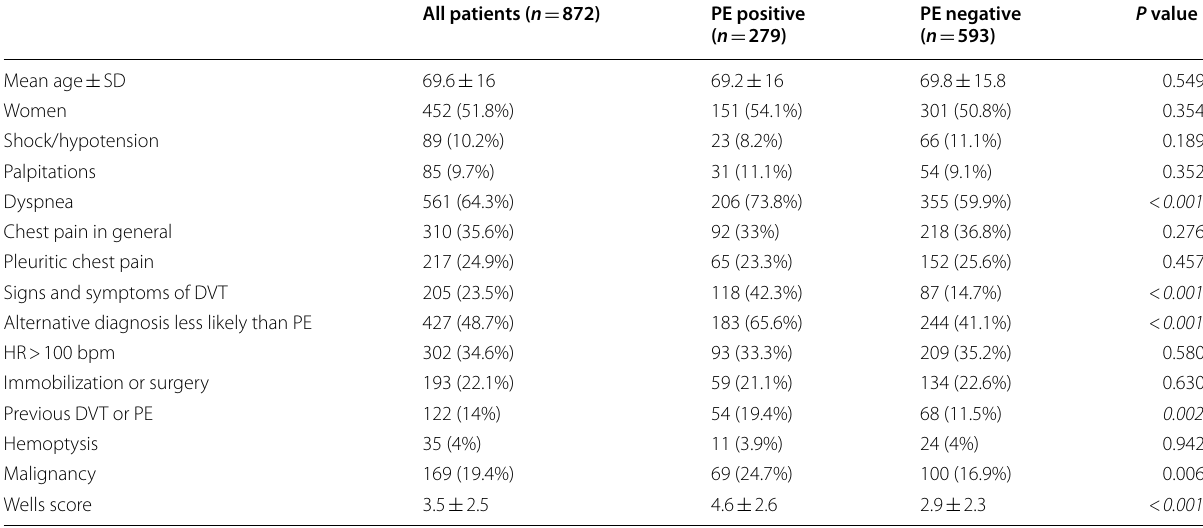
Data are presented as number of cases (with %) or mean DVT deep vein thrombosis, PE pulmonary embolism, HR heart rate